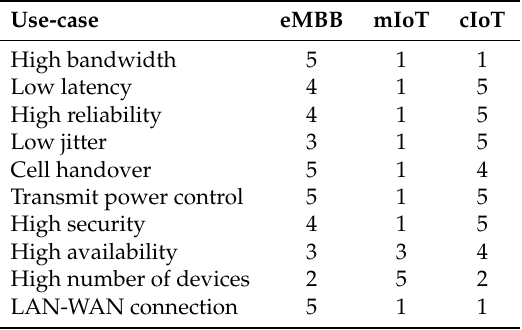
Table 1. Use-cases and their corresponding, important parameters (Scale-importance: tolerant/low: 1, normal/medium: 3, major/high: